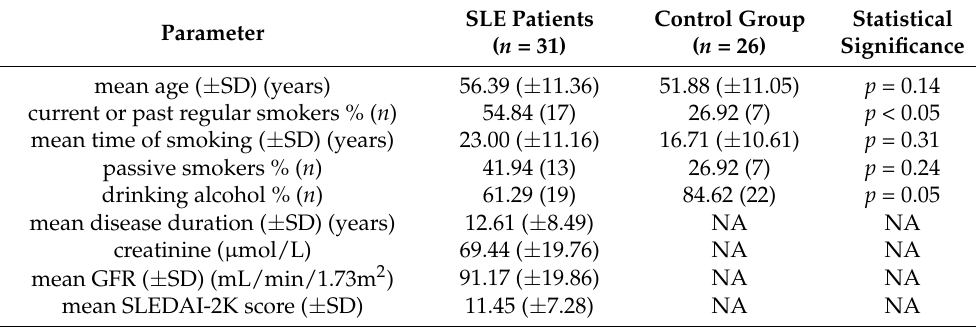
Table 1. Characteristics of the groups included in the